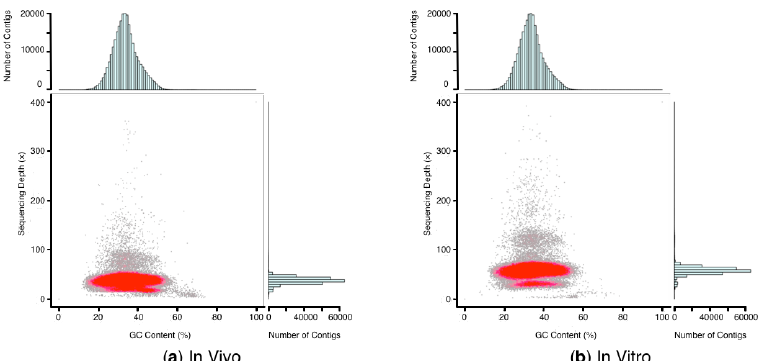
Figure 3. GC content and average sequencing depth distribution of in vivo ( a ) and in vitro ( b ) M. cordata after decontamination. The stray regions at high GC content and low depth were both shrunk dramatically compared to Figure 2. ( a ) Due to the relatively low sequencing depth of in vivo plant, the high-density region is more concentrated. However, there remains a small stray region at the low depth and high GC content. ( b ) Due to the relatively high sequencing depth of in vitro plantlets, there are two distinct high-density regions around 76 × and 38 × , which might be the homologous and heterologous sequences in the genome.